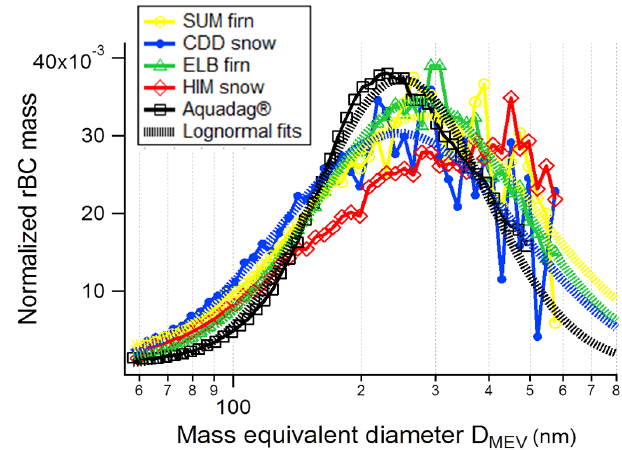
Figure 2. Mass size distributions of rBC in snow and firn samples from the different sites investigated. The y axis is d M/ dlog( D MED ) with all distributions normalized to an area of 1. Histogram bin size is